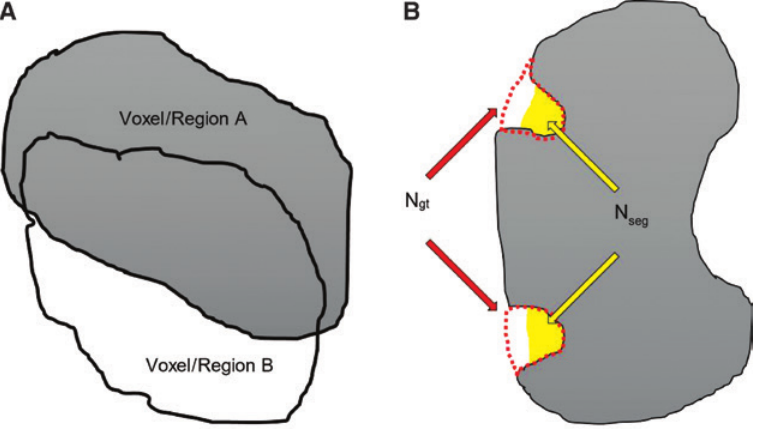
Figure 11: Delineation of Segmentation